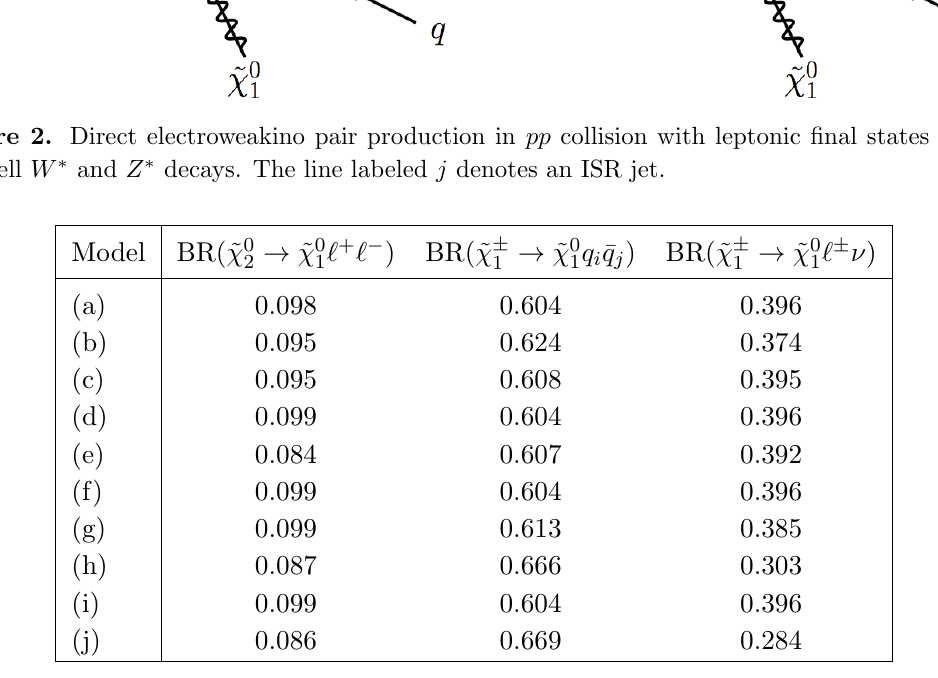
Table 4. The electroweakino branching ratios into the (cid:12)nal states shown in (cid:12)gure 2. In the table header, q i (cid:22) q j 2 f u (cid:22) d; u (cid:22) s; c (cid:22) d; c (cid:22) s g for ~ (cid:31) + electrons and